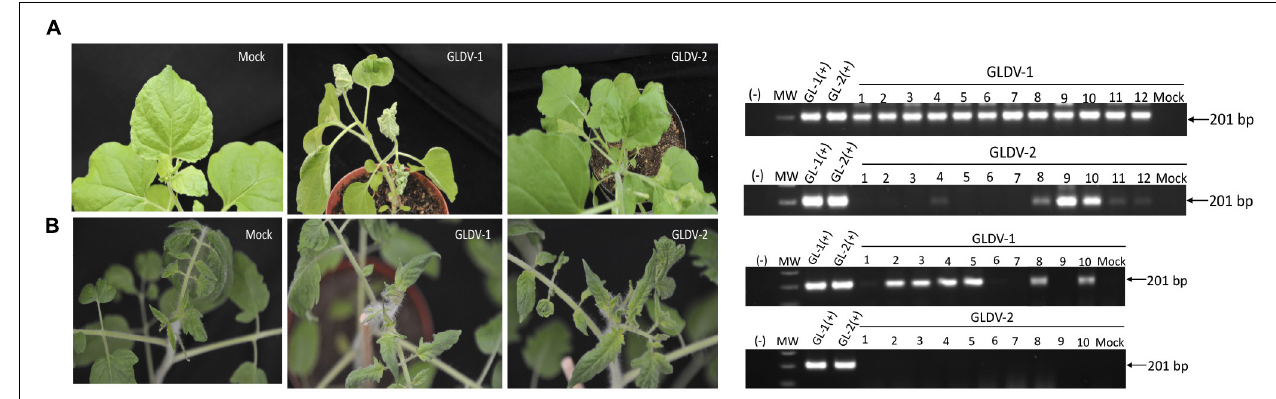
FIGURE 6 | Galium leaf distortion virus (GLDV) infectivity assay. Nicotiana benthamiana and Solanum lycopersycum plants were inoculated with GLDV-1 or GLDV-2 agroinfectious clones, and symptoms documented at 21 dpi ( A,B , right panel, respectively ) . Total DNA (100 ng) of N. benthamiana ( n = 12) and S. lycopersicum ( n = 10) plants inoculated with GLDV-1 or GLDV-2 agroinfectious clones was used as template for PCR molecular detection using GLDV specific primers ( A,B , left panel, respectively ) . (–), negative non template control, MW, molecular weight marker, GL-1 ( + ), and GL-2 ( + ), plasmidic positive controls of GLDV-1, and GLDV-2, respectively, Mock, control plant inculcated with agrobacterium harboring empty binary vector. The size of expected amplicon is